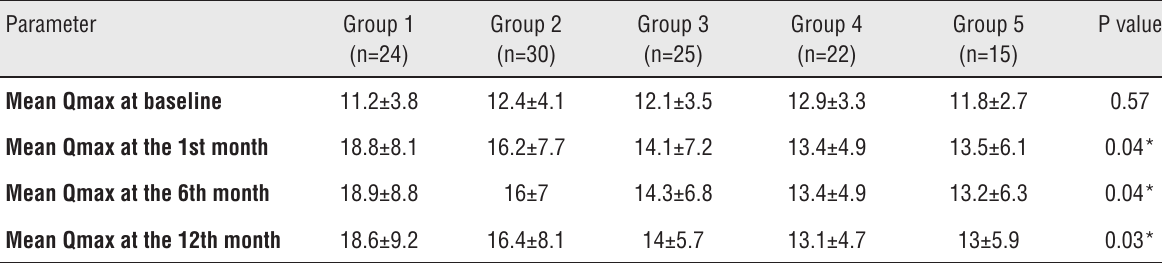
Table 2 - comparison of clinical findings on uroflowmetry in Groups.